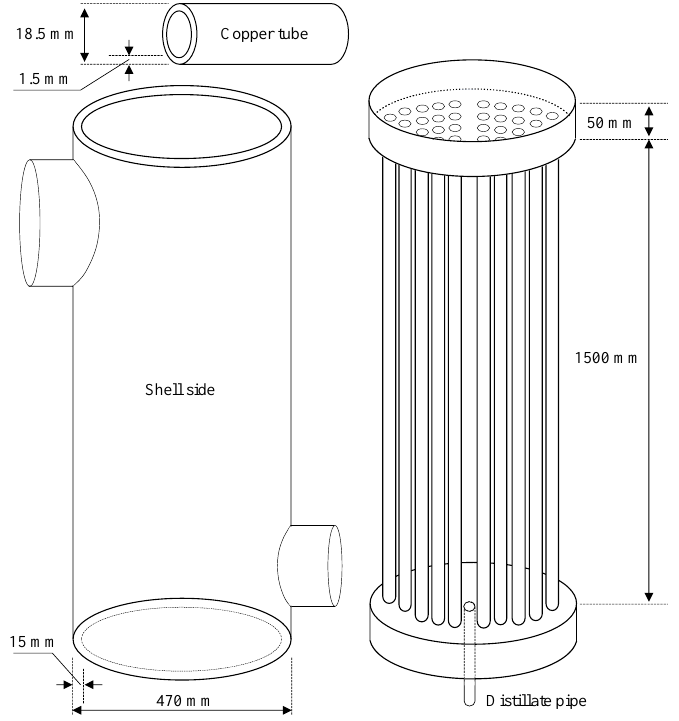
Figure 6. Schematic diagram of the dehumidifier.